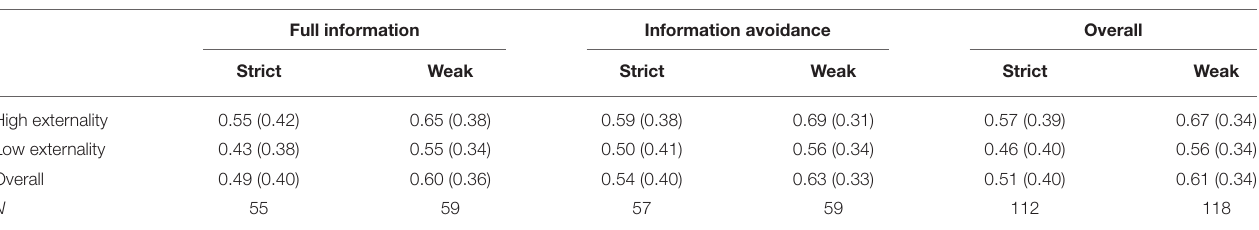
TABLE 2 | Mean share , by treatment. Full information Information avoidance Overall Strict Weak Strict Weak Strict